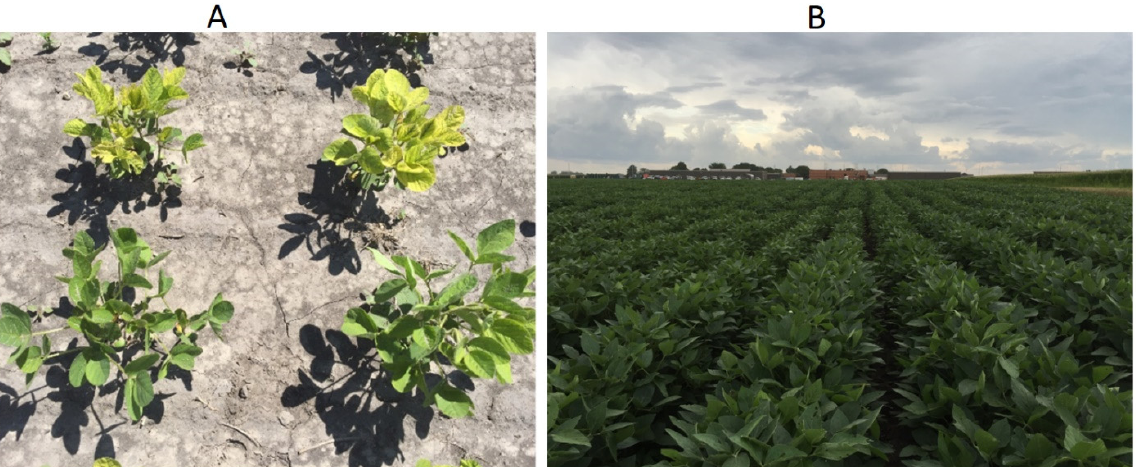
Figure 11. Images of IDC hill plots ( A ) vs. yield test plots ( B ). The left image shows the chlorosis phenotype of two susceptible testing lines (top two hill plots) and two resistant testing lines (bottom two hill plots). The right image shows yield test plots with plants in 10 m rows.